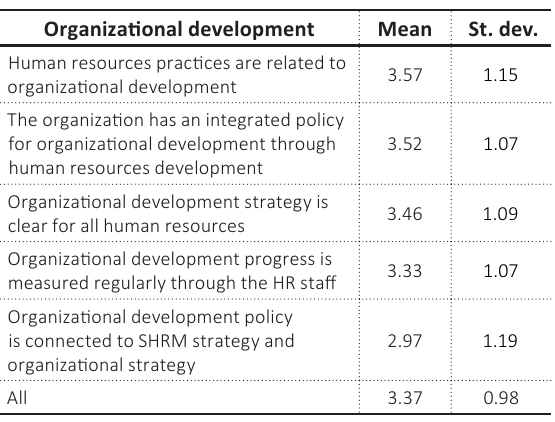
Table 4. Managers’ attitudes for the role